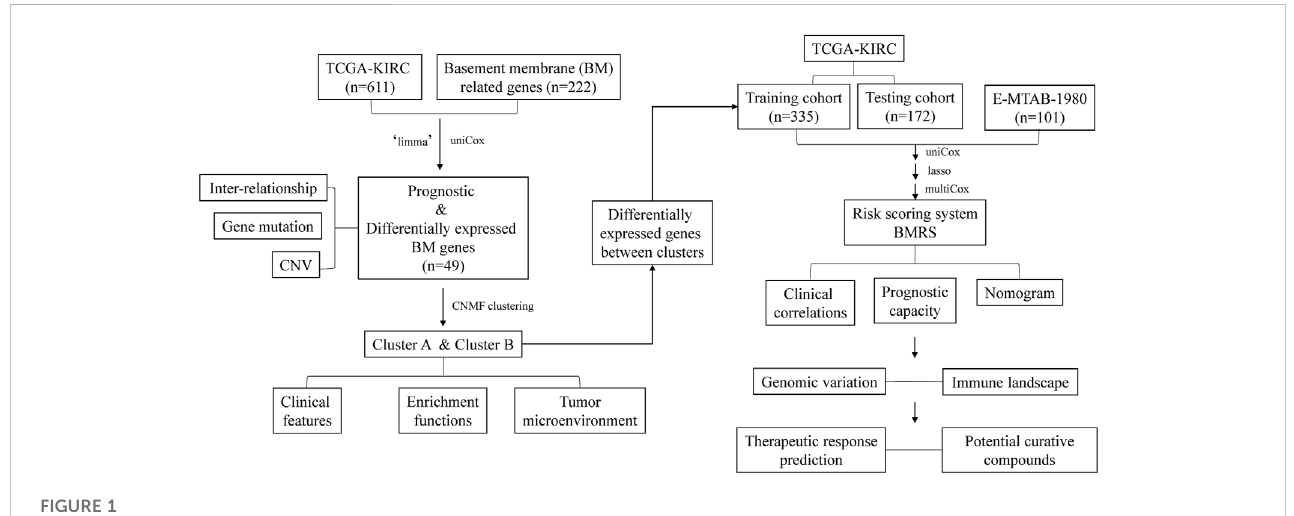
FIGURE 1 The fl ow chart of the current